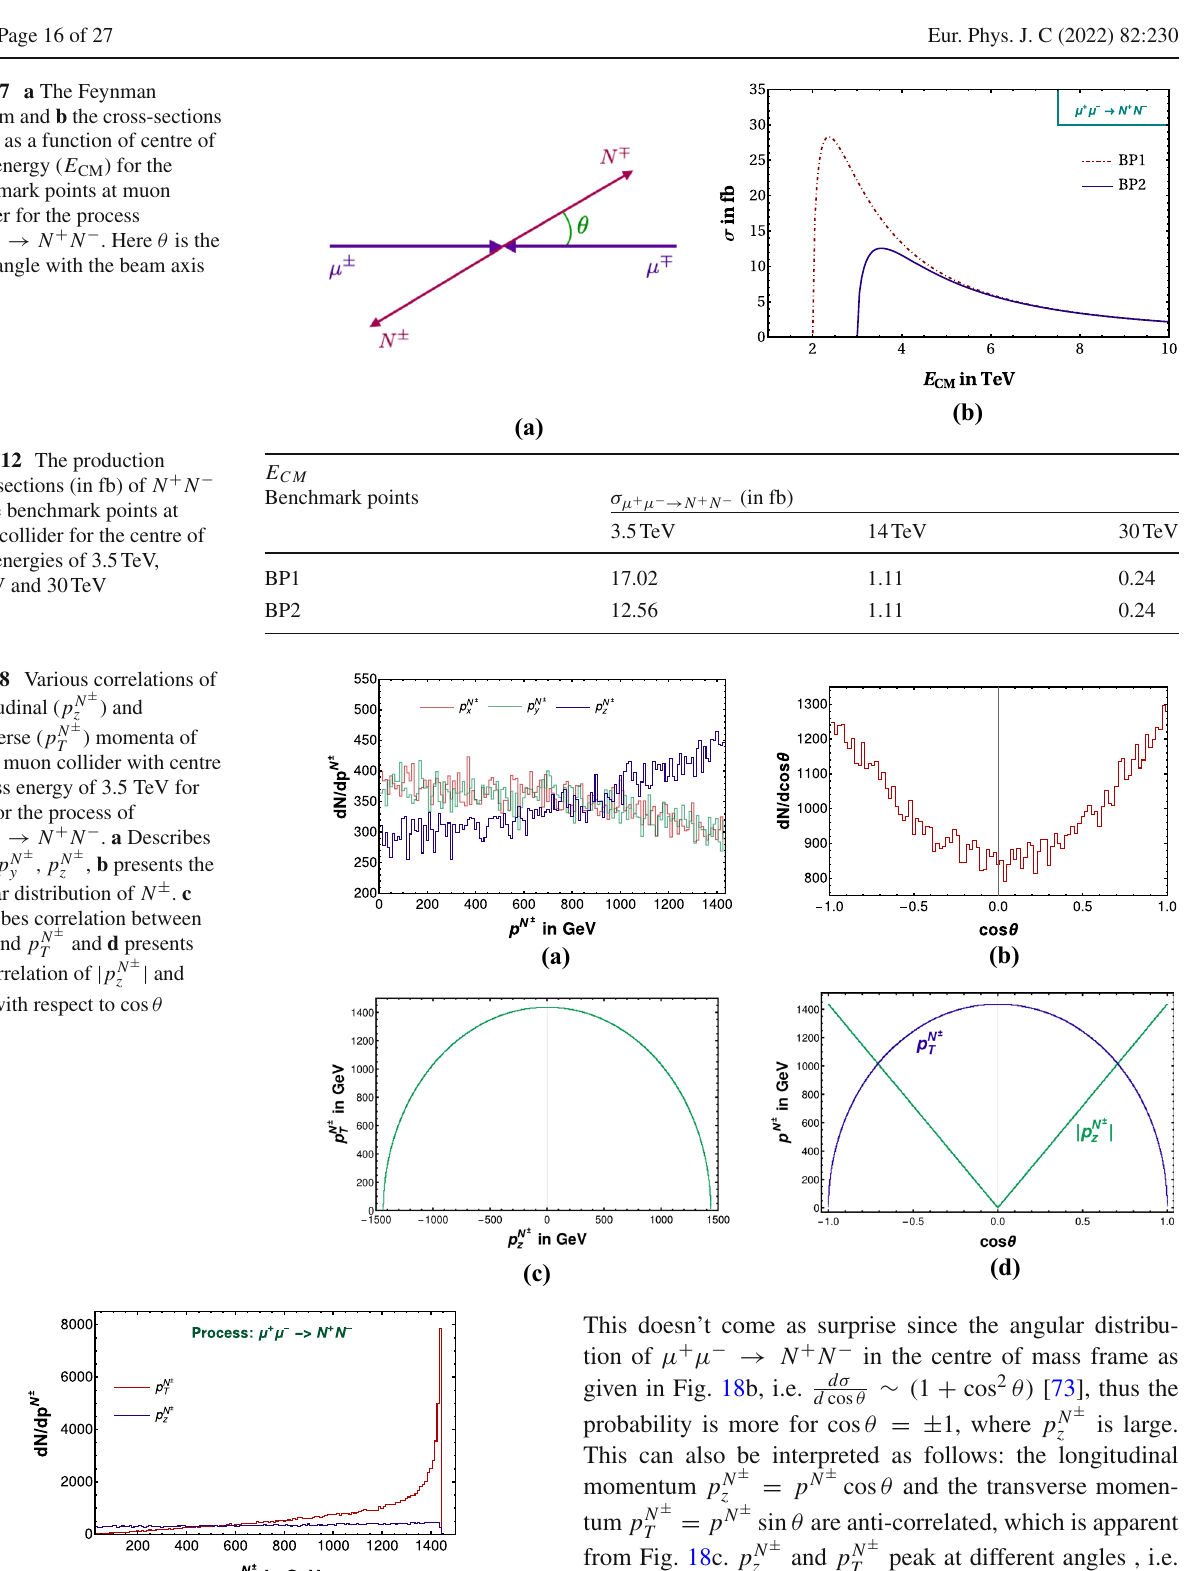
Fig. 19 The transverse ( p N ± ) and longitudinal ( p N ± z ) momenta dis- T tribution of the N ± at the muon collider with M N = 1TeV (BP1), Y N = 5 × 10 − 7 and center of mass energy 3.5